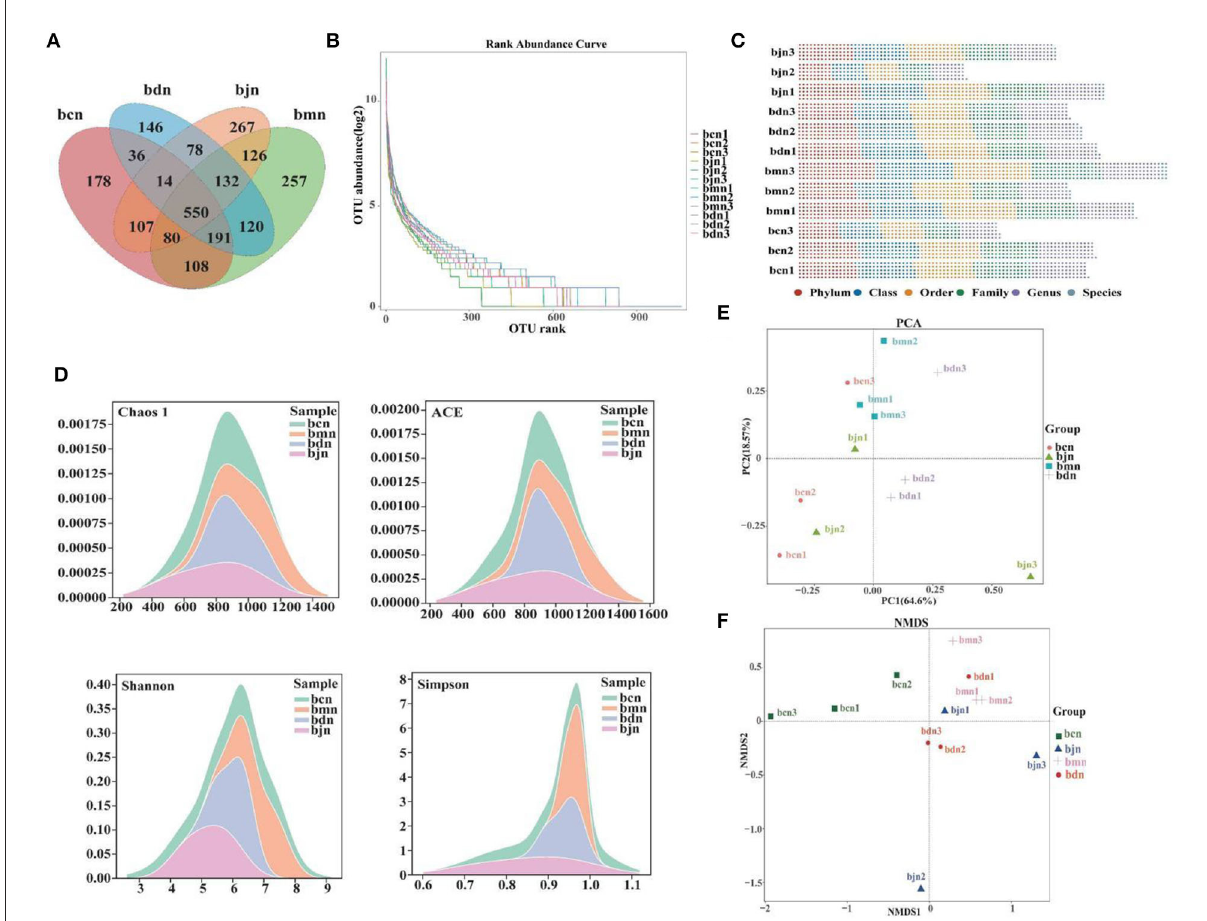
FIGURE4 OTU number and diversity of intestinal contents microbiota. (A) Venn diagram. (B) Rank abundance distribution curve. The longer the folded line, the greater the number of OTUs in the sample. The gentler the curve, the better the uniformity of the community; the steeper the curve, the lower the homogeneity of the community. (D) OTU number of each sample at different classification levels. (C) OTU in each sample at each classification level. (D) Chaos 1 index; ACE index; Shannon index; Simpson index. (E) PCA analysis. (F) NMDS analysis. Data were mean ± SD, n = 3, p > 0.05. bcn: normal saline-treated basal diet group; bmn: normal saline-treated high-fat diet group; bdn: DO traditional decoction-treated high-fat diet group; bjn: lipid-lowering decoction-treated high-fat diet